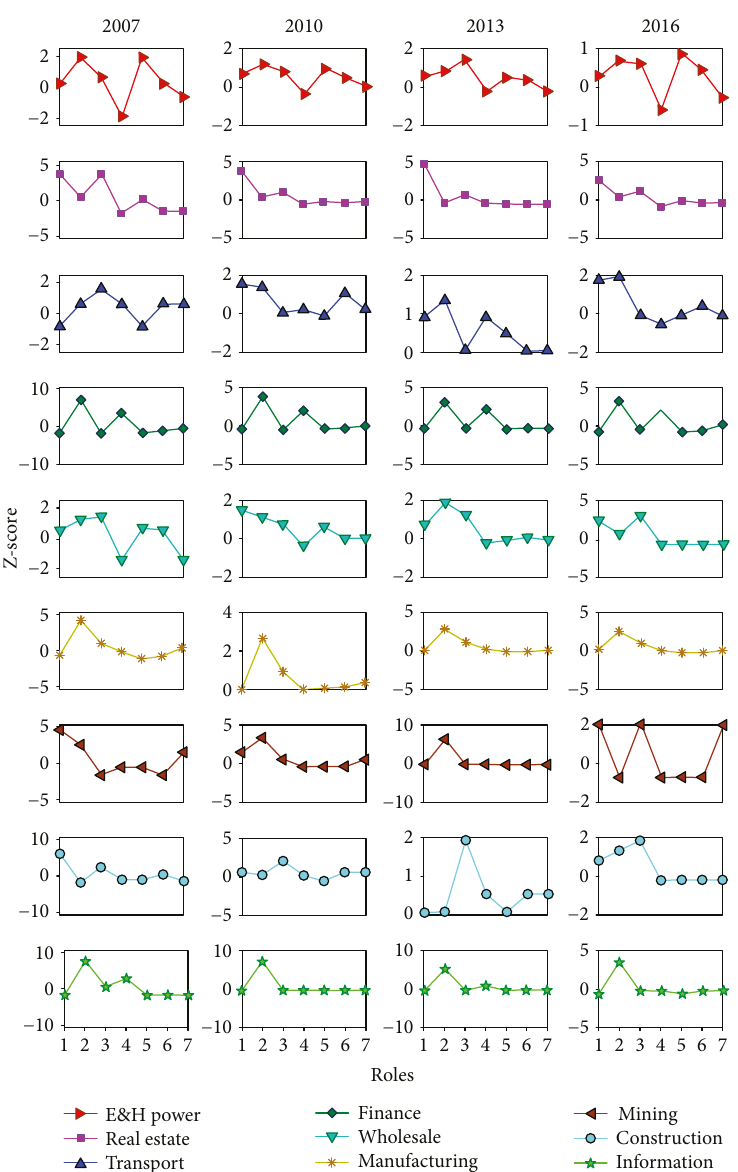
Figure 4: The changing tendency of the role distribution in main industries. The abscissas represent di ff erent roles; the characteristics of each role are presented in Figure